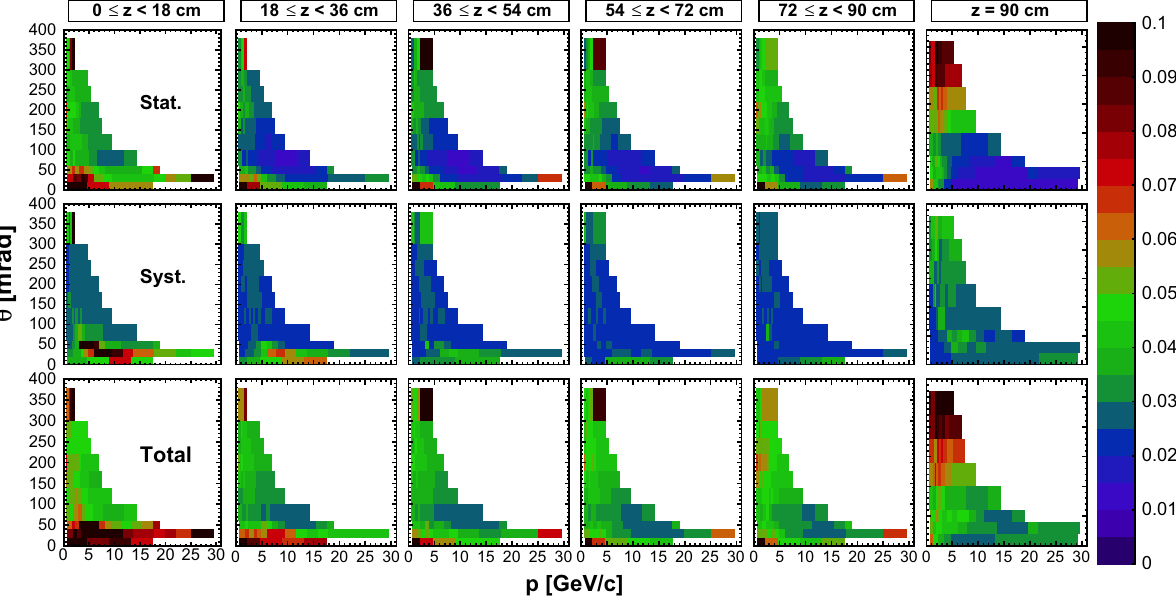
Fig. 21 Uncertainties on p yields shown as a function of p and θ : statistical uncertainties (top row), total systematic uncertainties (middle row) and total uncertainties (bottom row). Each column corresponds to a different longitudinal bin same number of TPC clusters. The selected tracks can